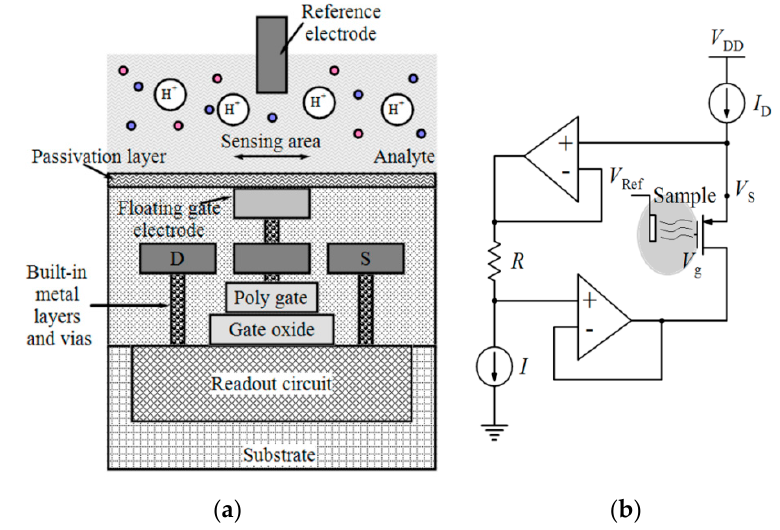
Figure 11. ( a ) ISFET fabricated by standard CMOS process, ( b ) An ISFET readout